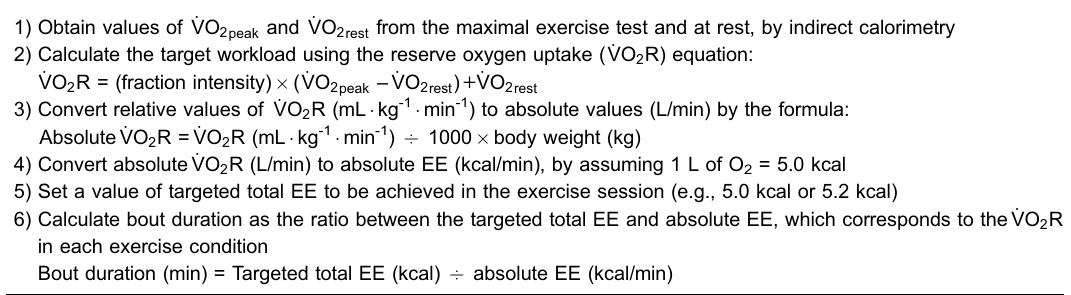
Table 1 . Determination of caloric cost of exercise session from 1) Obtain values of 2) Calculate the target workload using the reserve oxygen uptake ( VO 2 R = (fraction intensity) (cid:1) (